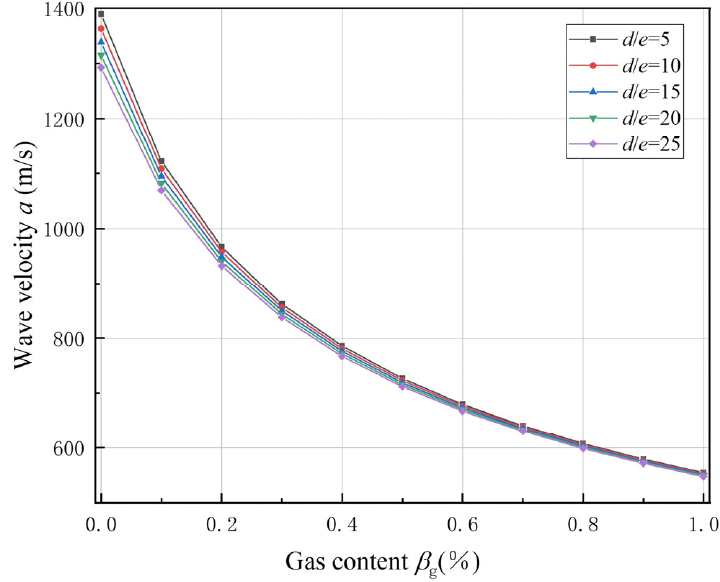
Figure 4. The effect of gas content and diameter–thickness ratio on wave velocity.